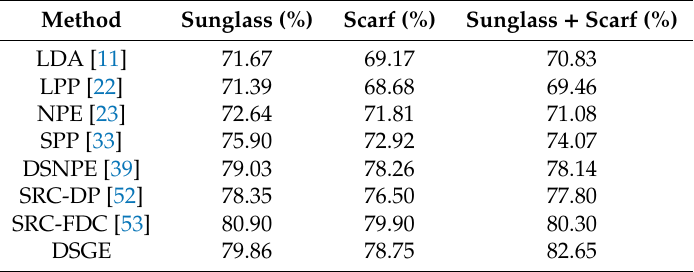
Table 2. The recognition rate of each method under three kinds of real occlusion on the AR databases.